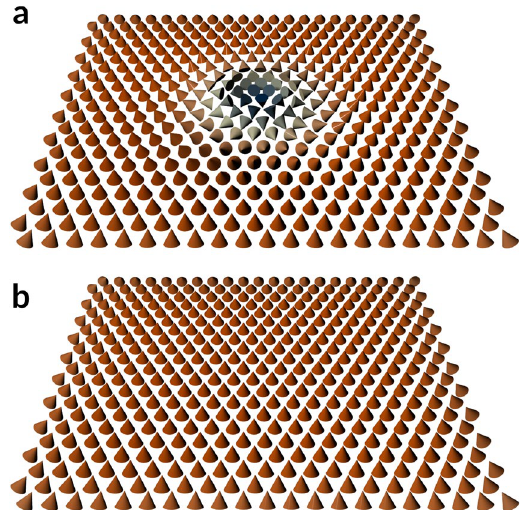
Figure 1. Magnetic configurations in a system with interfacial DMI. Representation of: ( a ) a Néel skyrmion and ( b ) a ferromagnetic ordering in a thin magnetic film with interfacial